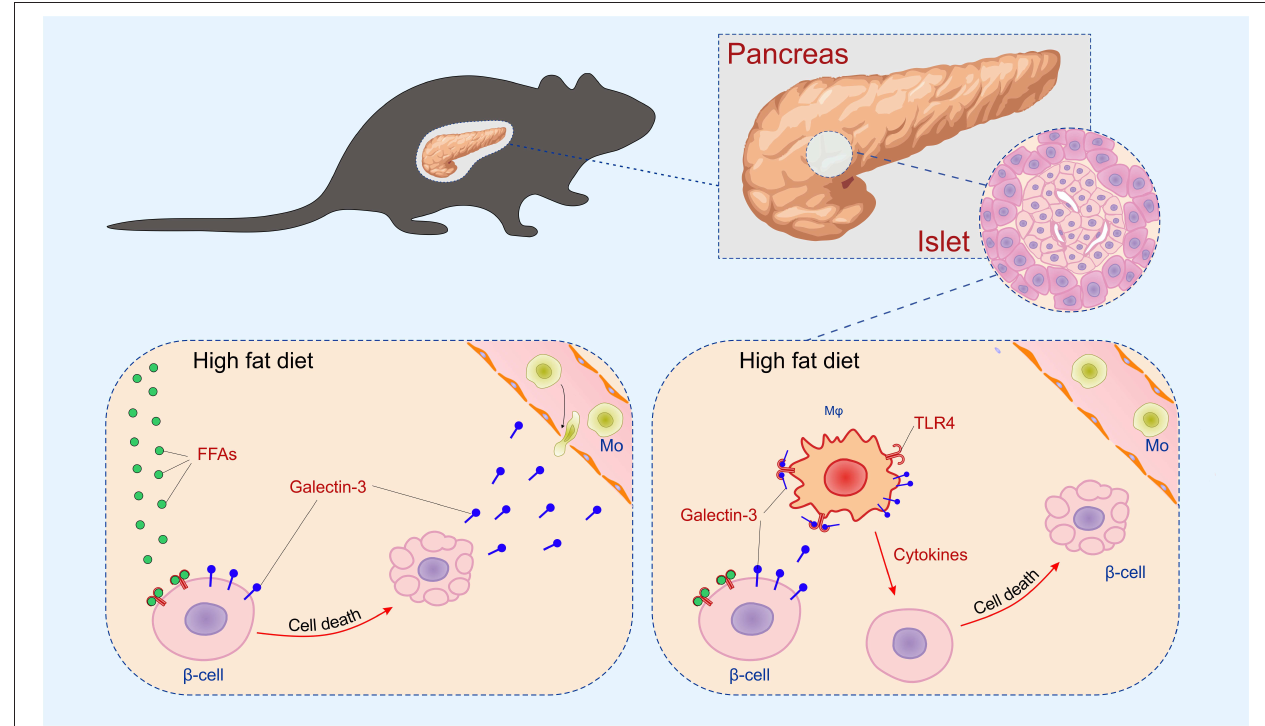
FIGURE 7 | Mechanism of islet inflammation aggravated by over-expression of galectin 3 on β cells. Saturated NEFA, increased by HFD feeding, activate TLR4 on β cells and induce their initial damage (Left) . Galectin 3 released from damaged β cells in a paracrine manner stimulates macrophage migration to the islet, which aggravates inflammation and further cell damage (Right)